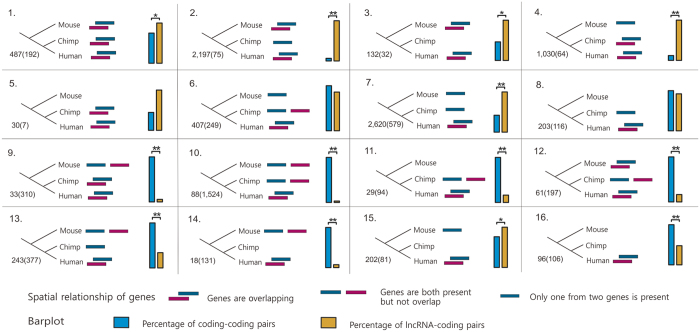
Evolutionary scenarios of human lncRNA-coding pairs and coding-coding pairs.Numbers of pairs are shown, outside the parenthesis for lncRNA-coding pairs and inside for coding-coding pairs. The bars in boxes represent the proportion of overlapping pairs with the evolutionary pattern in all corresponding pairs and asterisks indicate the statistical significance of different proportions between lncRNA-coding pairs and coding-coding pairs (one asterisk for p value < 0.05 and two for p value < 10−5).